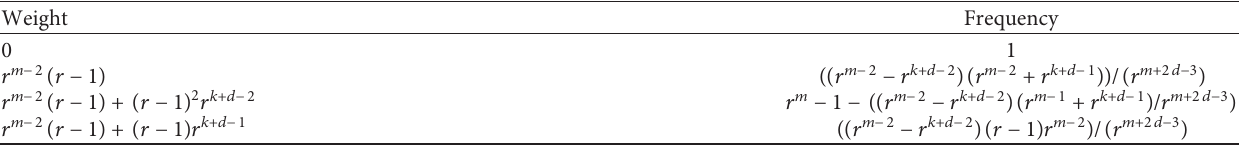
S for Theorem 3 (i).